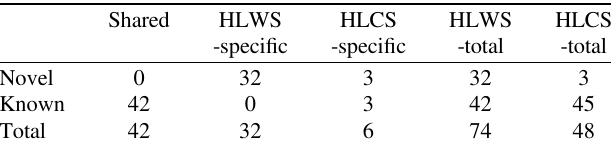
Table 3. Comparison of miRNA pro fi les in HLWS and